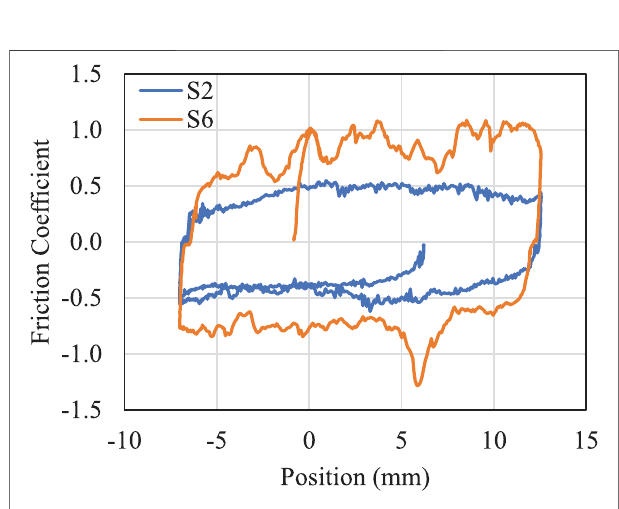
FIGURE 9 | Friction energy dissipation during the particle – particle friction measurement for samples S2 and S6.